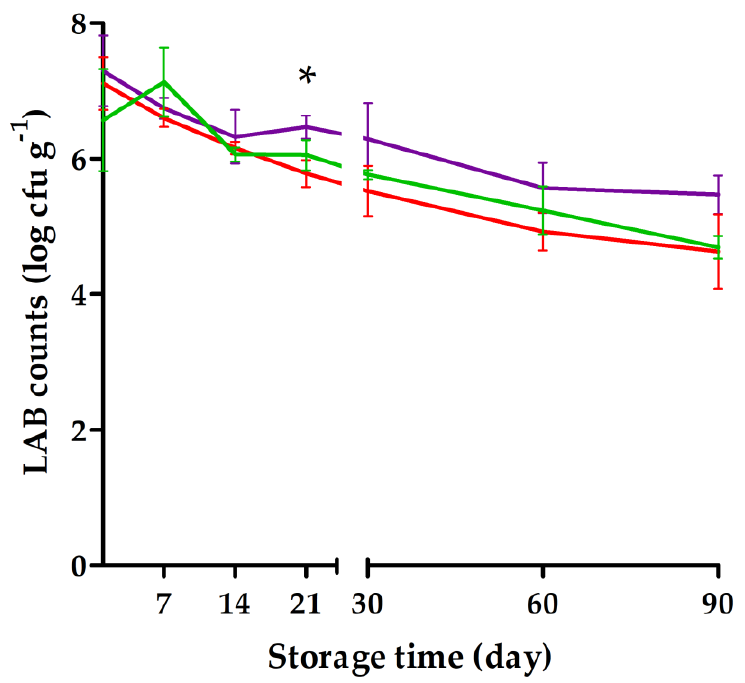
Figure 2. The viable counts of lactic acid bacteria (log colony forming units (cfu) g −1 , average ± SD) of the frozen blackcurrant products during 90-day storage at −20 °C. Sugar-only flavored black- currant product ( ), product flavored with sugar and vanilla ( ), and product flavored with sugar, vanilla, and lemon ( ). The sugar-only flavored blackcurrant product was significantly different from that of the product flavored with sugar and vanilla at an individual time point: * p < 0.05 (Tukey test). Results are means of triplicates.